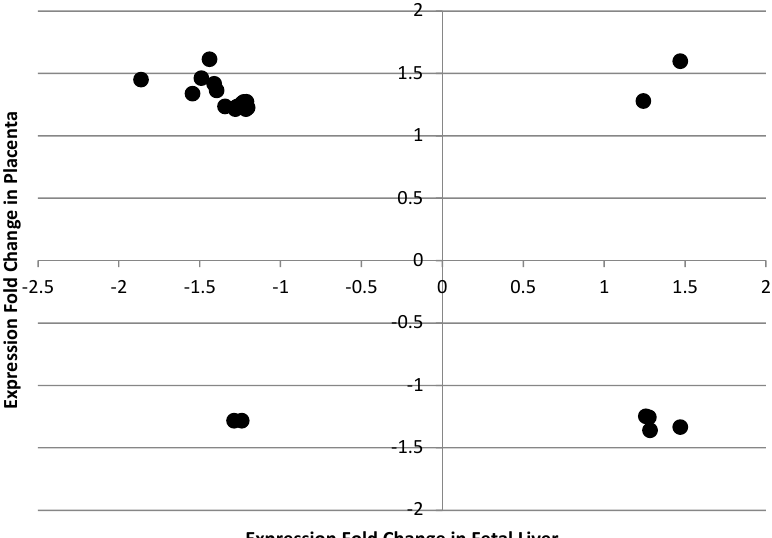
Figure 1. Scatterplot summarising the direction and level of fold change in expression of genes which were altered in both fetal liver and placenta by maternal folate depletion 1,2,3 . 1 The Low and Normal folate diets contained 0.4 and 2.0 mg folic acid/kg diet respectively; 2 For each comparison, data were obtained from three male fetuses from each of six litters from dams fed either the Low or Normal folate diets; 3 A negative fold change indicates lower expression in offspring from dams fed the Low folate diet.